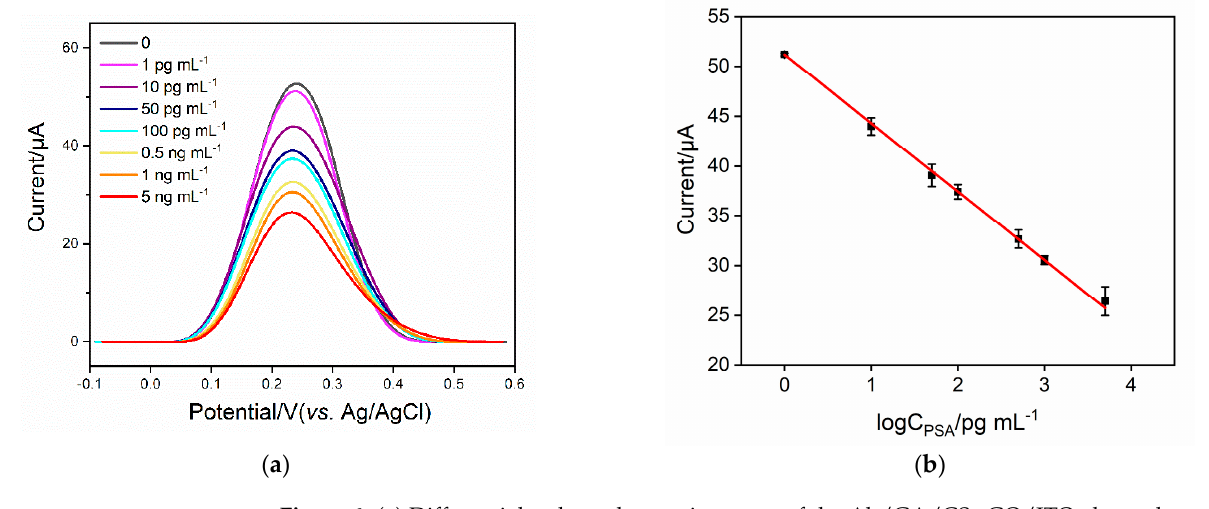
Figure 6. ( a ) Differential pulse voltametric curves of the Ab/GA/CS-rGO/ITO electrode towards various concentrations of PSA. ( b ) The corresponding calibration curves to determine PSA using the Ab/GA/CS-rGO/ITO electrode. Error bars represent the standard deviation of three measurements.